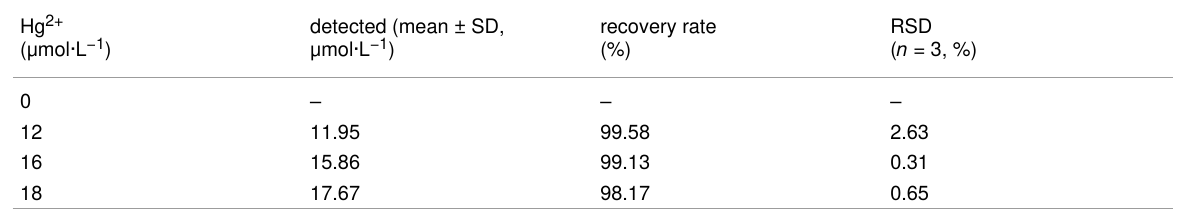
Table 1: Determination of Hg 2+ in tap water.